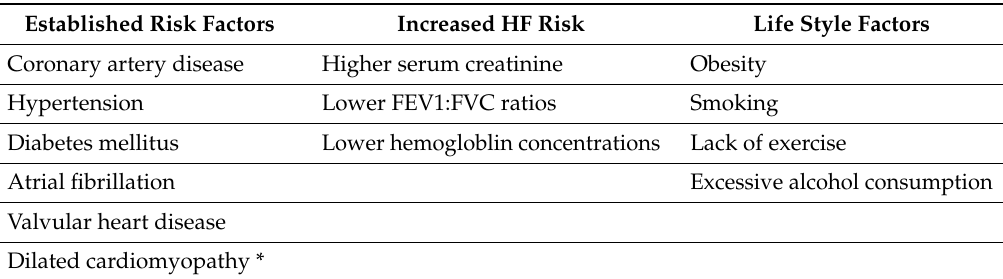
Table 1. Risk factors for heart